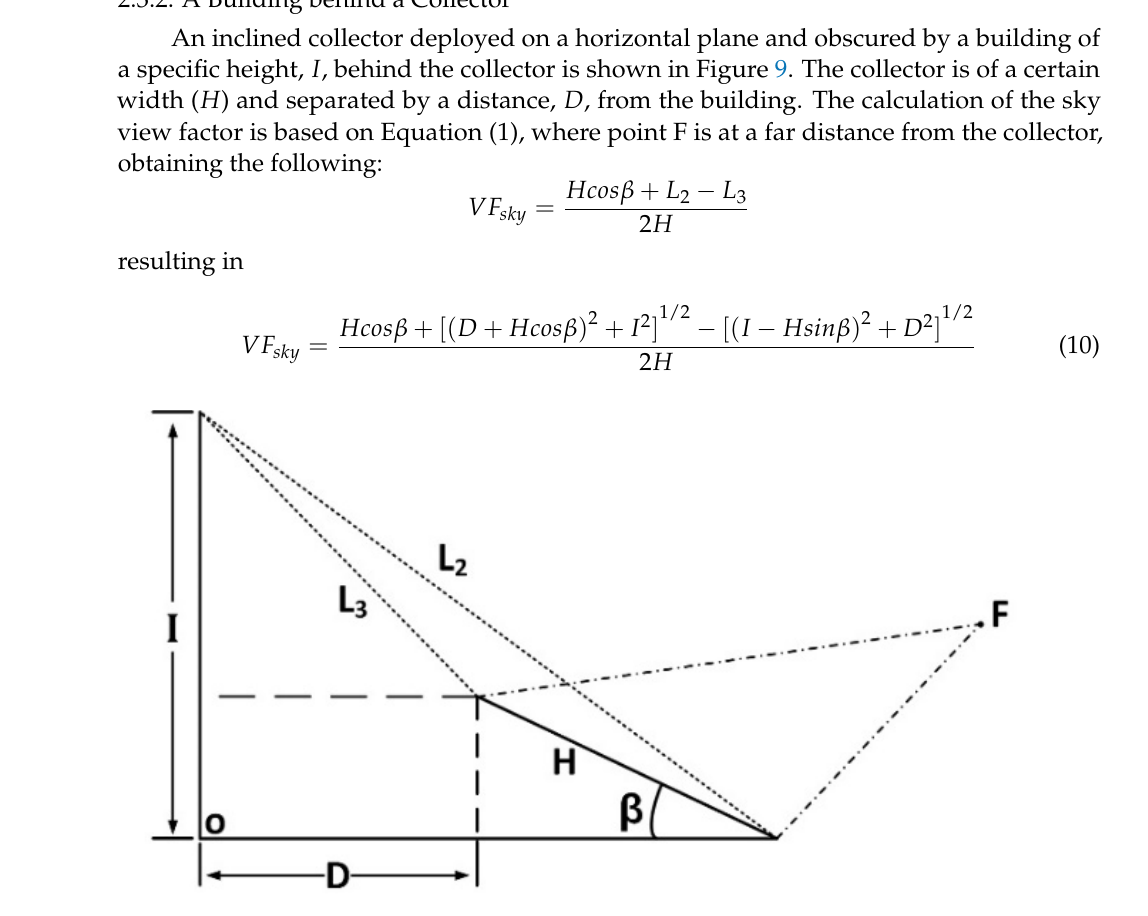
Figure 9. Collector obscured by a building behind.